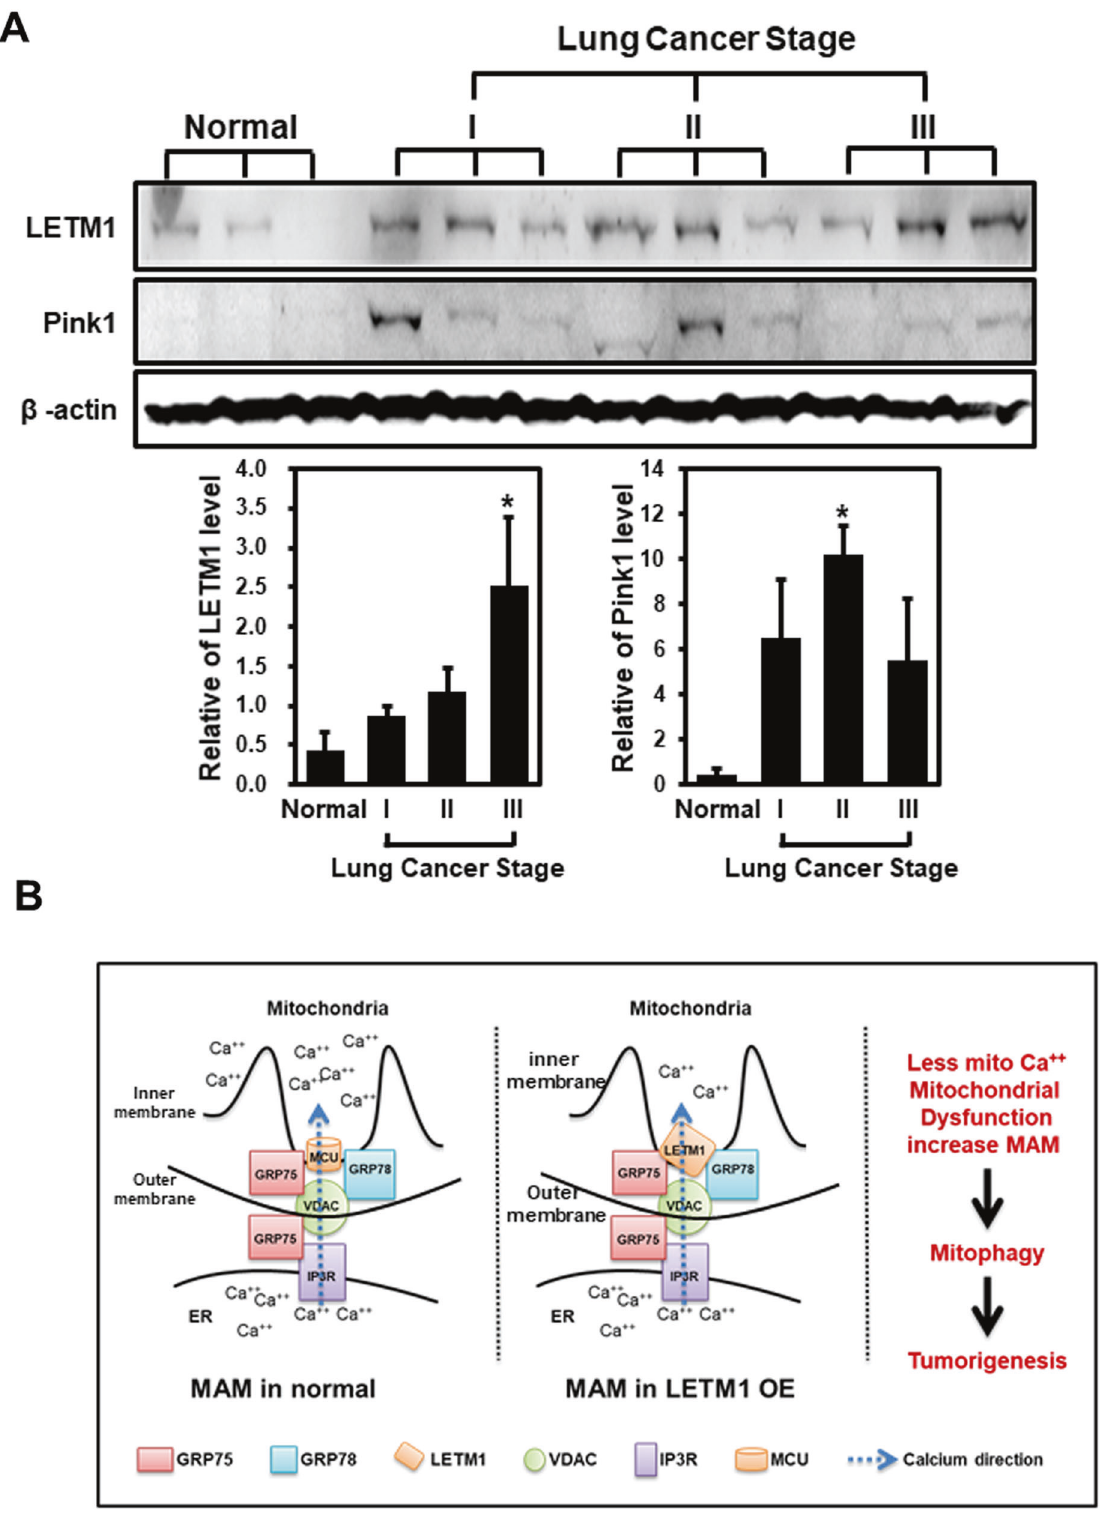
Fig. 7 A suggested model of LETM1 function in tumorigenesis. A The human samples were collected and lysate and following by a western blot analysis with anti-LETM1, anti-PINK1 and anti-Actin antibodies. The blots were then quanti fi ed by using ImageJ software (NIH, Bethesda, MD, USA). The relative expression of indicated protein (LETM1, PINK1) was calculated by normalizing all density values to that of actin in each lane. The results are displayed as mean ± SD and are representative of three independent samples. * p < 0.05. The proposed model of the role of LETM1 overexpression in mitophagy and tumorigenesis. B Overexpression of LETM1 induces mitochondria-associated ER membrane (MAM) by interacting with GRP78 and/or GRP75 and consequently reducing Ca ++ uptake. The formation of MAM, as triggered by LETM1 overexpression, leads to mitochondrial dysfunctions such as fragmentation, defects in Ca ++ and mPTP homeostasis, and loss of MMP, resulting in mitophagy. Mitophagy induced by LETM1 overexpression in lung cancer cells is advantageous for tumorigenesis. Cell Death and Disease (2022)